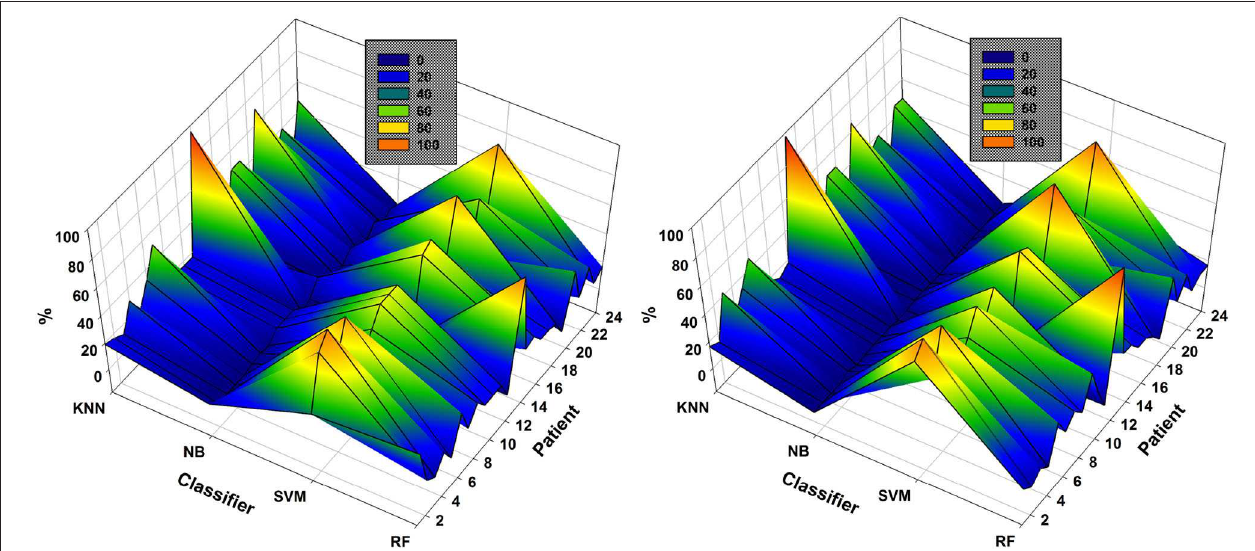
FIGURE 7 | Comparison of the most-used classifiers by NSGA-II (left) and NSGA-III (right) for the 24 patients with DWT-based feature